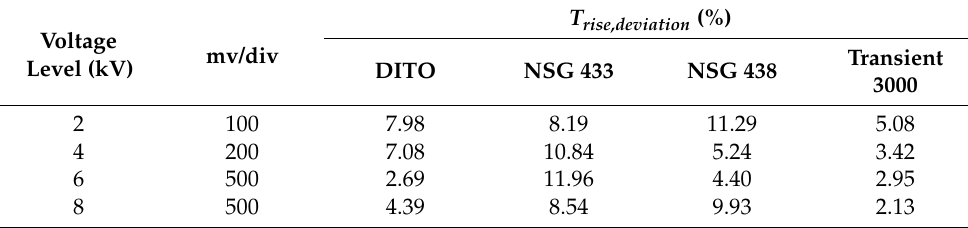
Table 8. T rise deviation for different test levels and ESD generators